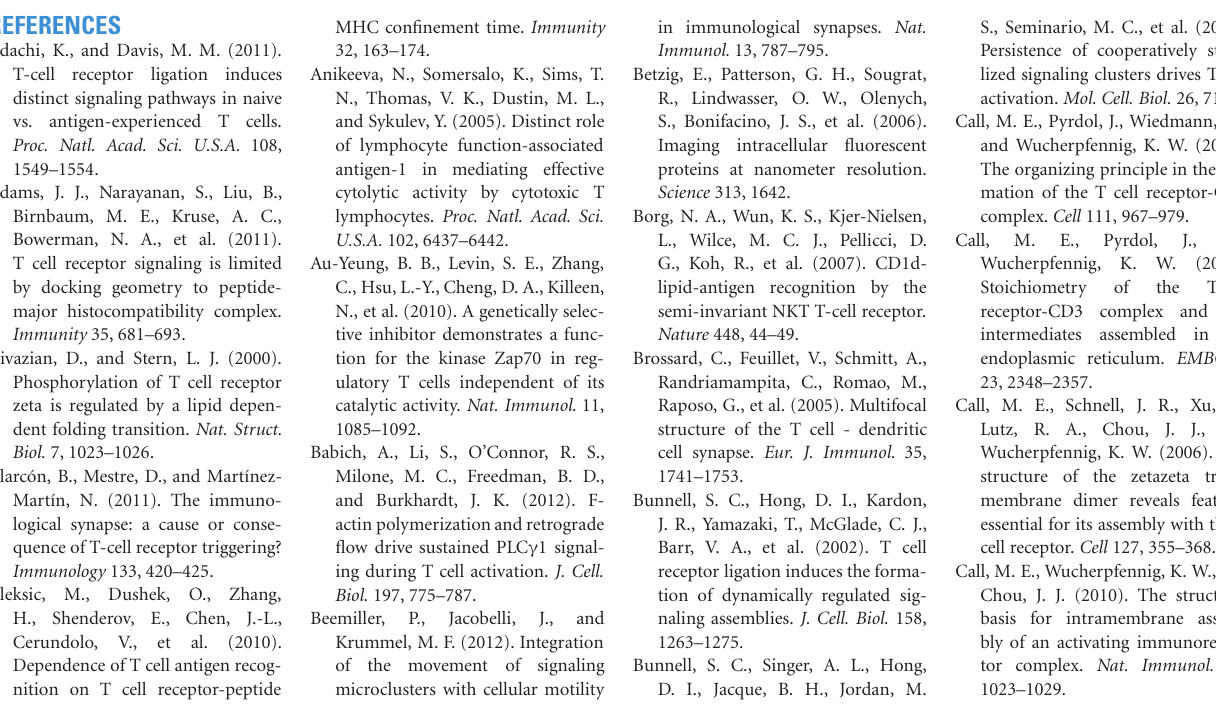
FIGURE 5 | Mechanisms that contribute to the spatial organization of TCR signaling processes include mechanical forces (black arrow), membrane tension due to convoluted membrane topography (red